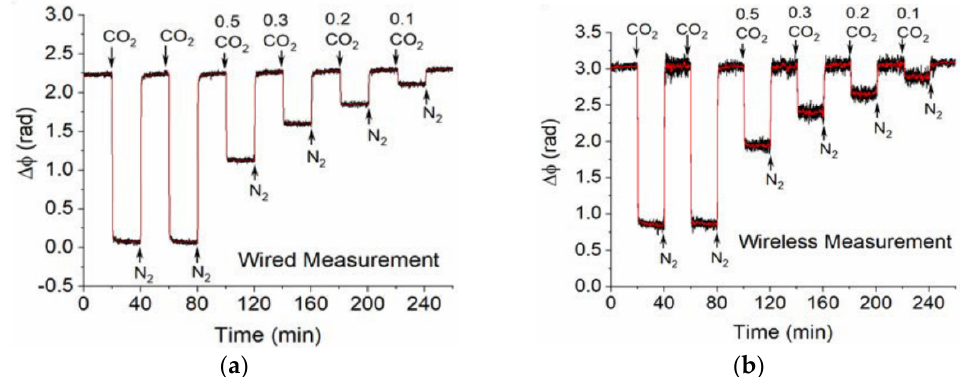
Figure 21. Responses of a surface acoustic wave (SAW) sensor coated with zeolitic imidazolate framework-8 (ZIF-8) metal-organic framework (MOF) film to various concentrations of CO 2 through wired or wireless measurements (© 2018 IEEE. Reprinted with permission from Reference [238]).